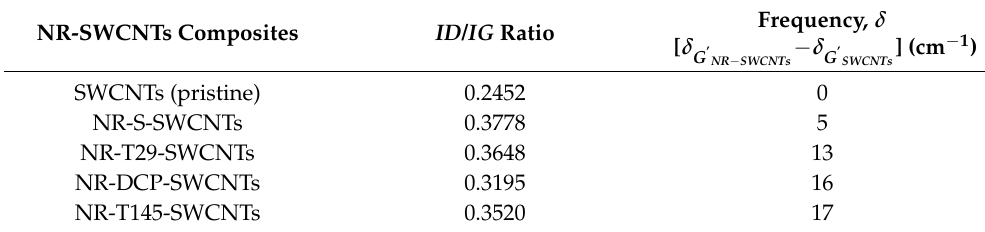
Table 7. I D / I G ratio of the NR-SWCNTs composites with different vulcanization